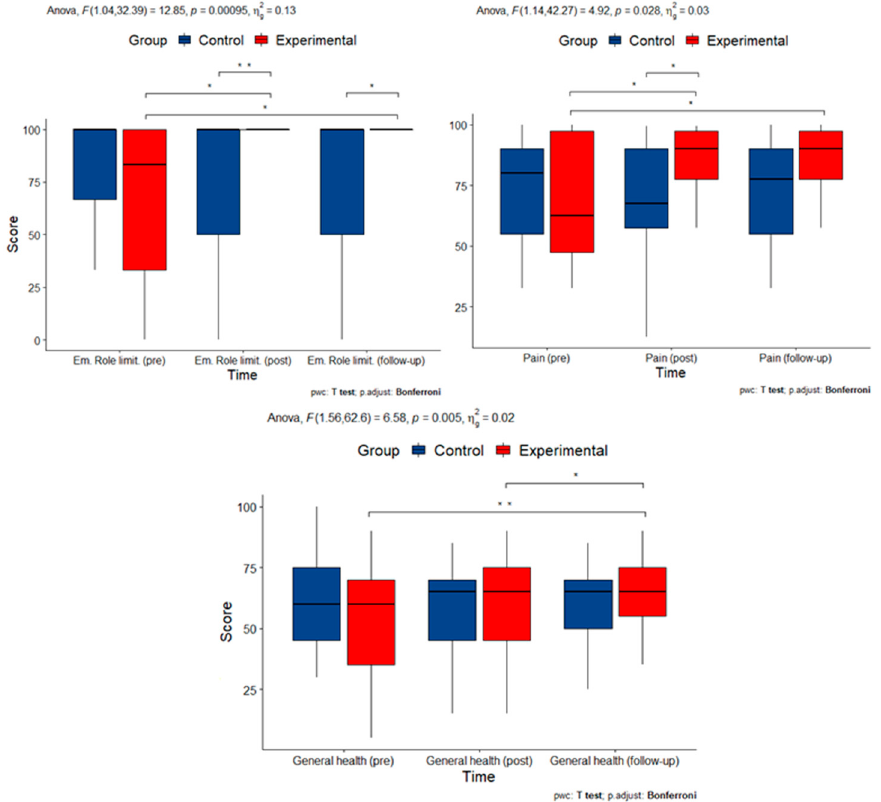
Figure 3. Box plots of measurements of quality-of-life indices with statistically significant interac- tions (Em. Role: Emotional Role subscale; pre: pre-intervention; post: post-intervention). Asterisks denote statistically significant pairwise comparisons.